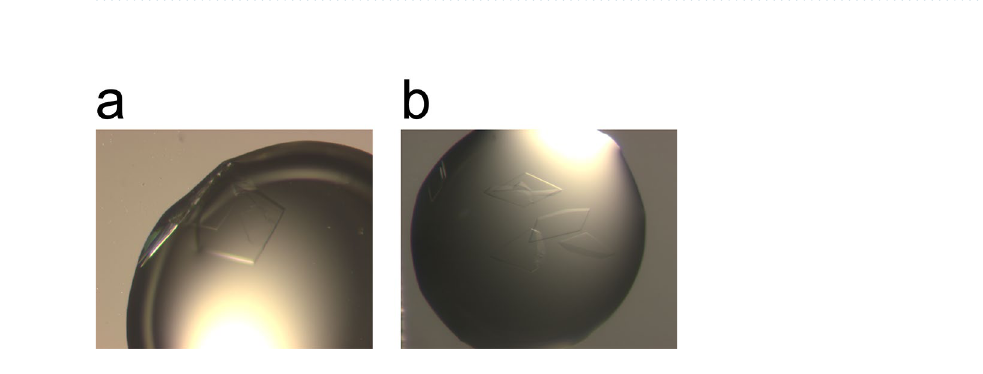
Figure 6. Crystallization of p62 PH. ( a ) p62 PH crystallized in KCl. ( b ) p62 PH crystallized in